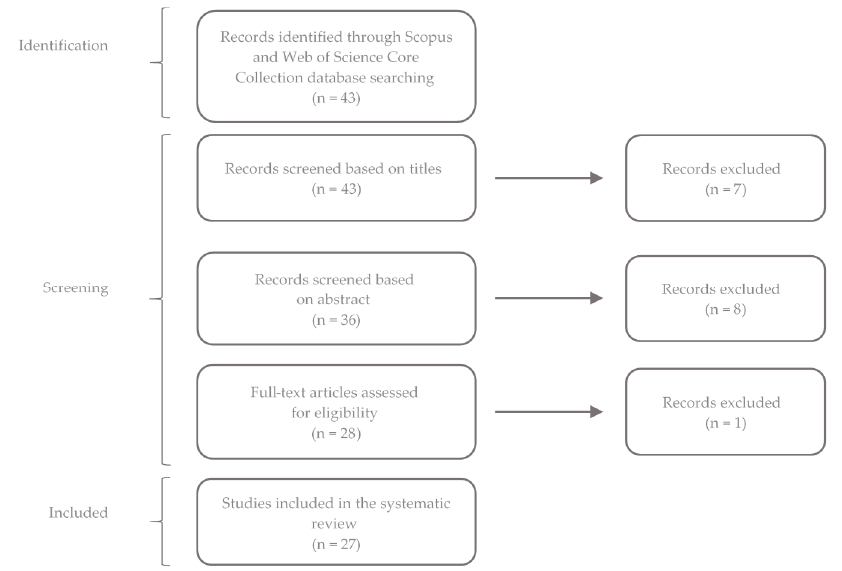
Figure 1. Selection of literary sources. Dominant subject areas (categories) of the publications were agricultural and